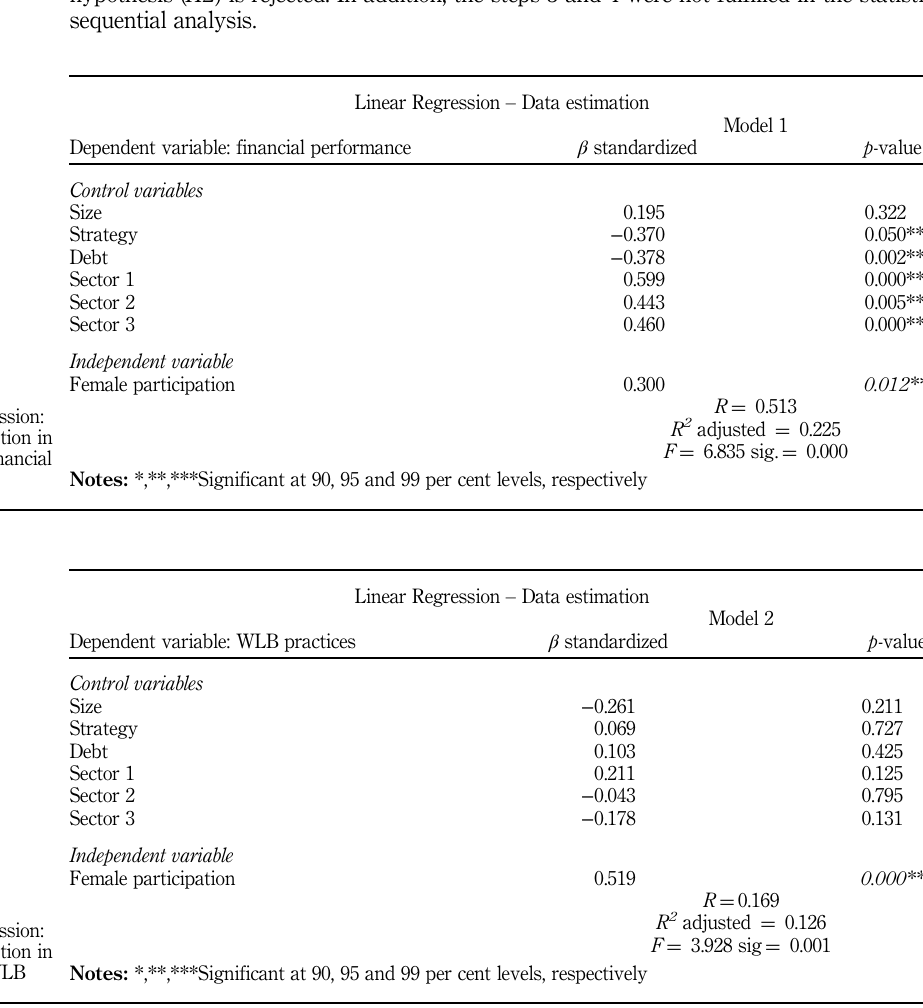
Table V. Results of regression: female participation in workforce on